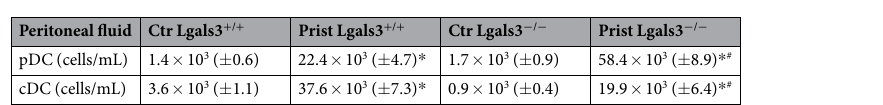
Table 3. Number of DC in the peritoneal fluid 18 h after pristane injection. Ctr: control mice; Prist: pristane- injected mice. ( * ) indicates p < 0.05 to pristane-treated mice compared with respective controls. ( # ) indicates p < 0.05 to pristane-induced Lgals-3 − / − mice compared with pristane-induced Lgals-3 + / +